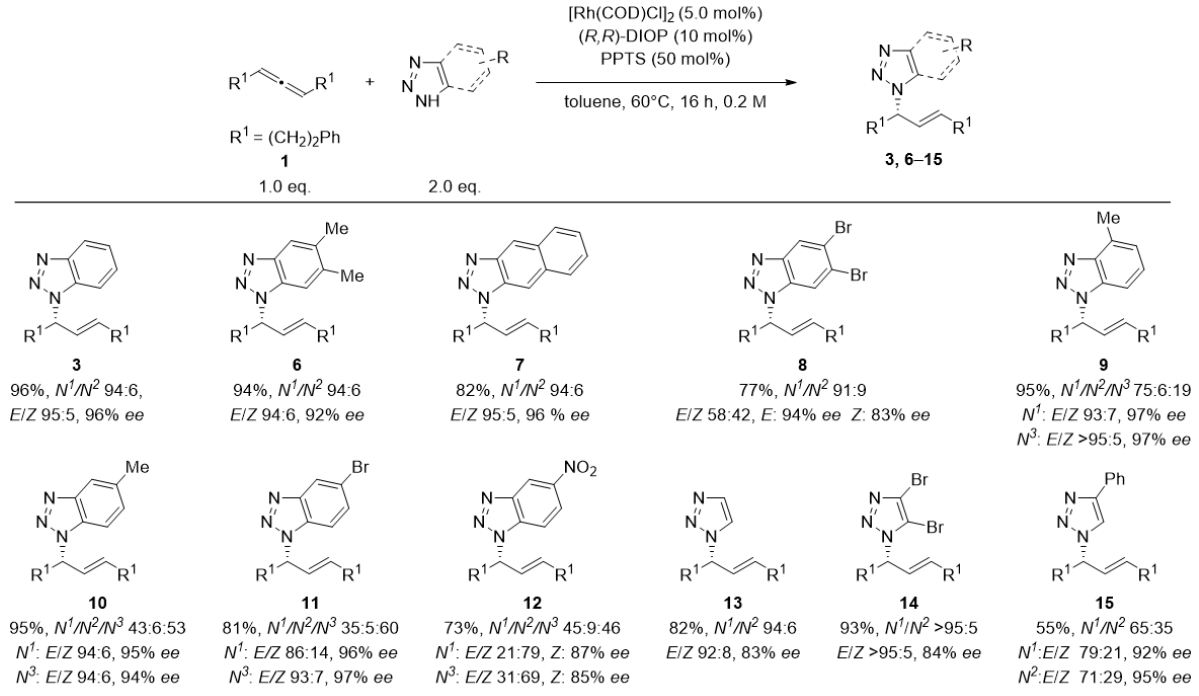
Figure 2. Scope of the addition of Triazoles to rac-1,7-diphenyl-hepta-3,4-diene ( 1 ). Reactions were performed at 0.25 mmol scale. Cumulative yield for all isolated isomers. E/Z -selectivities determined by 1 H-NMR. Enantioselectivities were determined by HPLC analysis using a chiral stationary phase. Unless specified, ee -values refer to main-stereoisomer of the main-regioisomer. Shown regioisomer is designated as an N 1 -product.